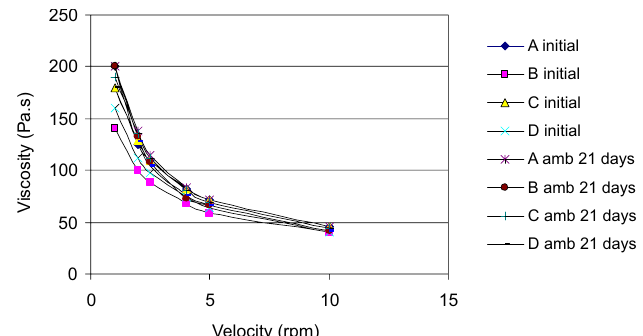
FIGURE 2 - Rheogram of formulations 24 hours after preparation and after 21 days stored at room temperature and at 60 °C. Values expressed in centipoise. A: vehicle; B: vehicle plus propolis extract; C: vehicle plus tocopheryl acetate; D: vehicle plus propolis extract and tocopheryl acetate. TABLE II - Apparent viscosity (mPa.s) of formulations stored at room temperature and at 60 °C, over a 21-day period calculated at maximum gradient strength Formulation